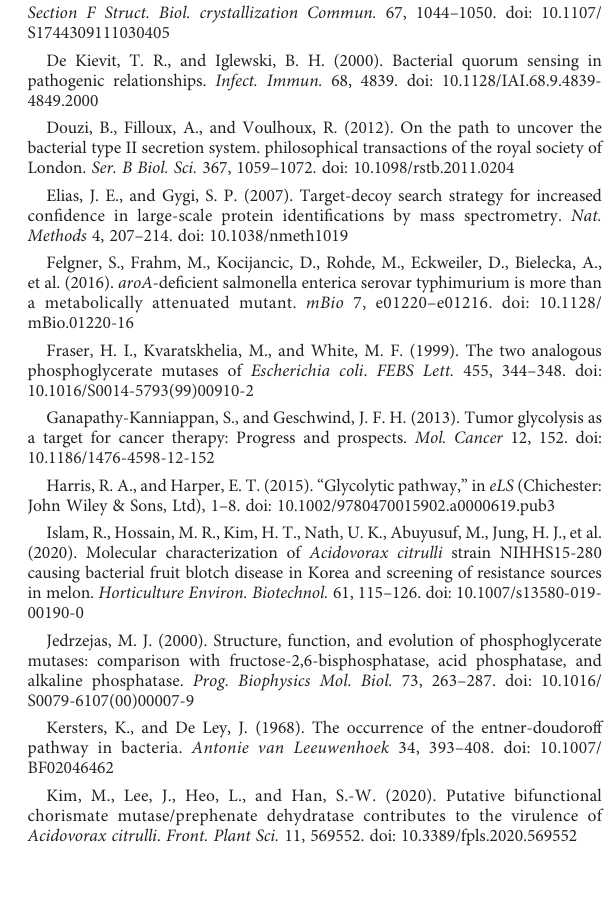
SUPPLEMENTARY FIGURE 1 Growth assay in TSB and M9 minimal media with mannitol and sucrose. Bacterialgrowthin (A) TSBandM9minimalmediawith (B) mannitol(0.4%) and (C) sucrose (0.4%). The values at OD 600nm were evaluated for fi ve and tendays inTSBandminimalmedia,respectively.Theerrorbarsfromthree biological replicates indicate the standard deviation and different characters above the error bars indicate signi fi cant differences according to ANOVA (p<0.05) with Tukey ’ s HSD test. At least four independent experiments were performed, all of which exhibited similar